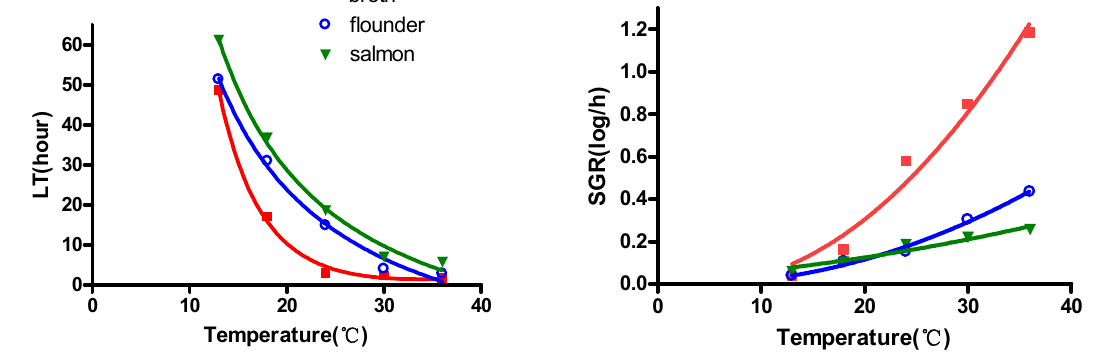
Figure 1. Effect of temperature on the values of Lag time (LT) and Specific growth rate (SGR) of V. parahaemolyticus in broth, flounder, and salmon sashimi. Data (n = 4) for LT and SGR were fitted using Equations (2) and (3),